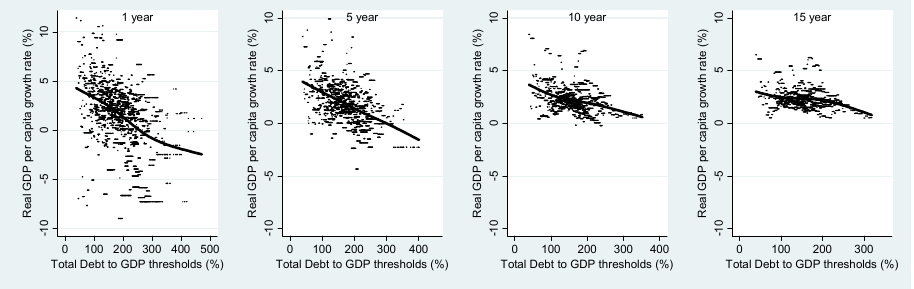
Figure 3 - Total debt and medium- to long-term economic